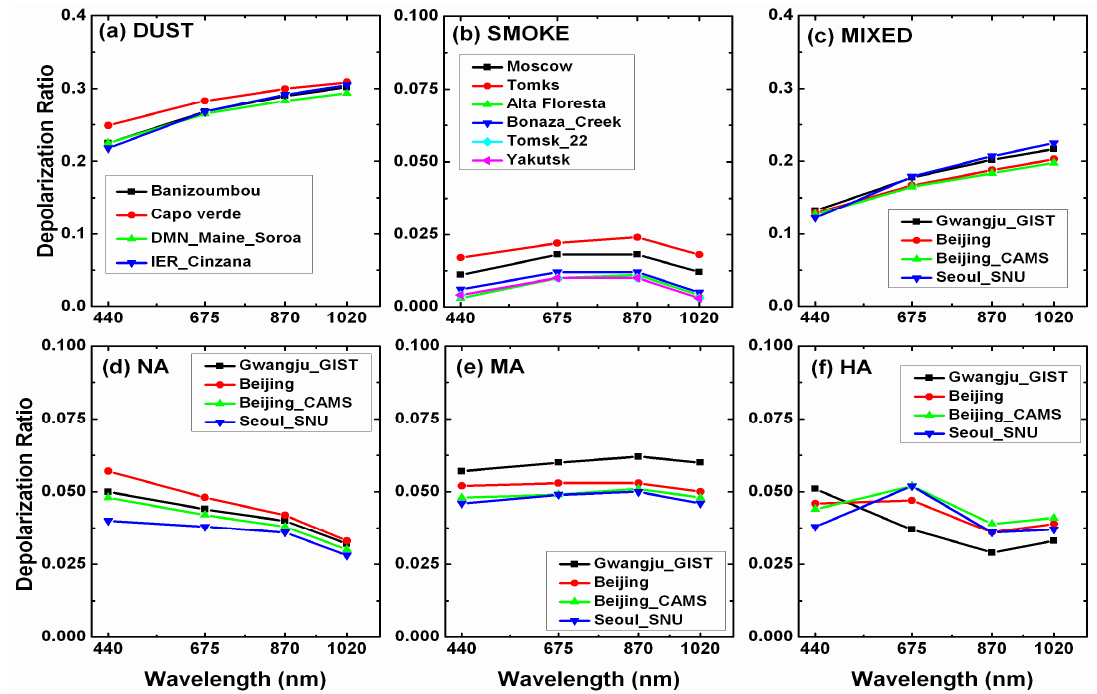
Figure 5. Spectral variation of the particle linear depolarization ratios for dust, smoke, mixed, non- absorbing (NA), moderate-absorbing (MA) and high-absorbing (HA) pollution particles,